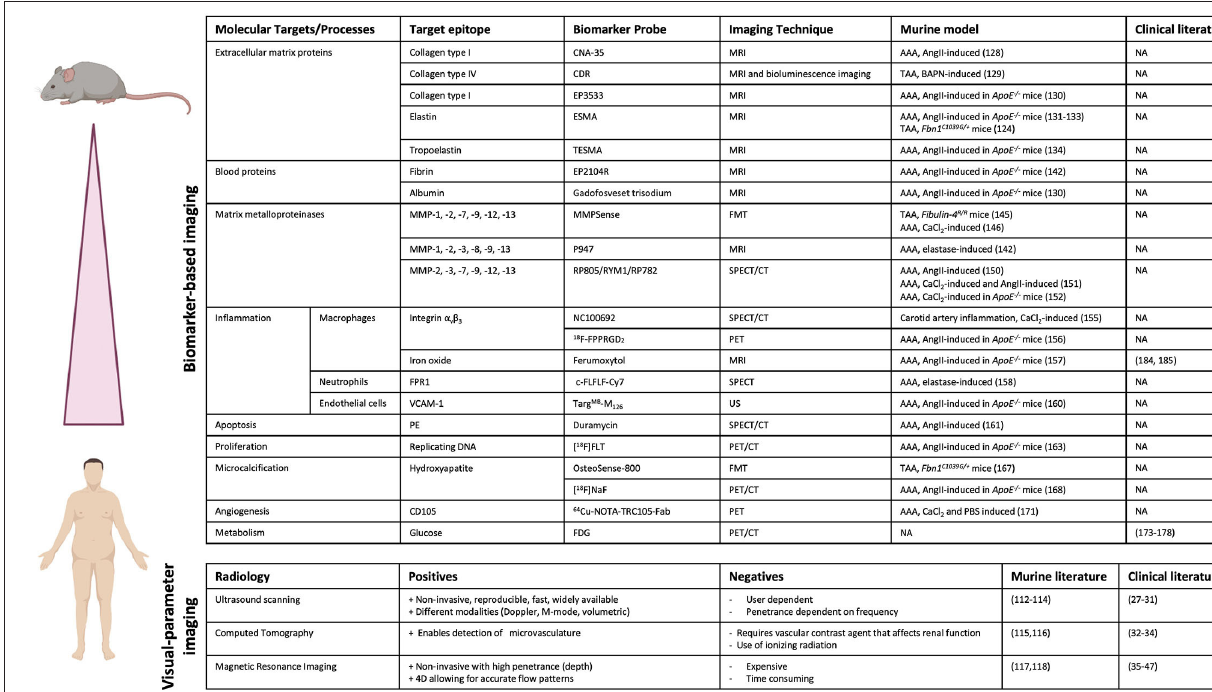
FIGURE 4 | Pre-clinical and clinical imaging techniques for AA. Overview of biomarker-based imaging techniques and visual parameter-based imaging techniques that have been tested in pre-clinical trials using murine models and/or in clinical trials with patients. (Picture created with